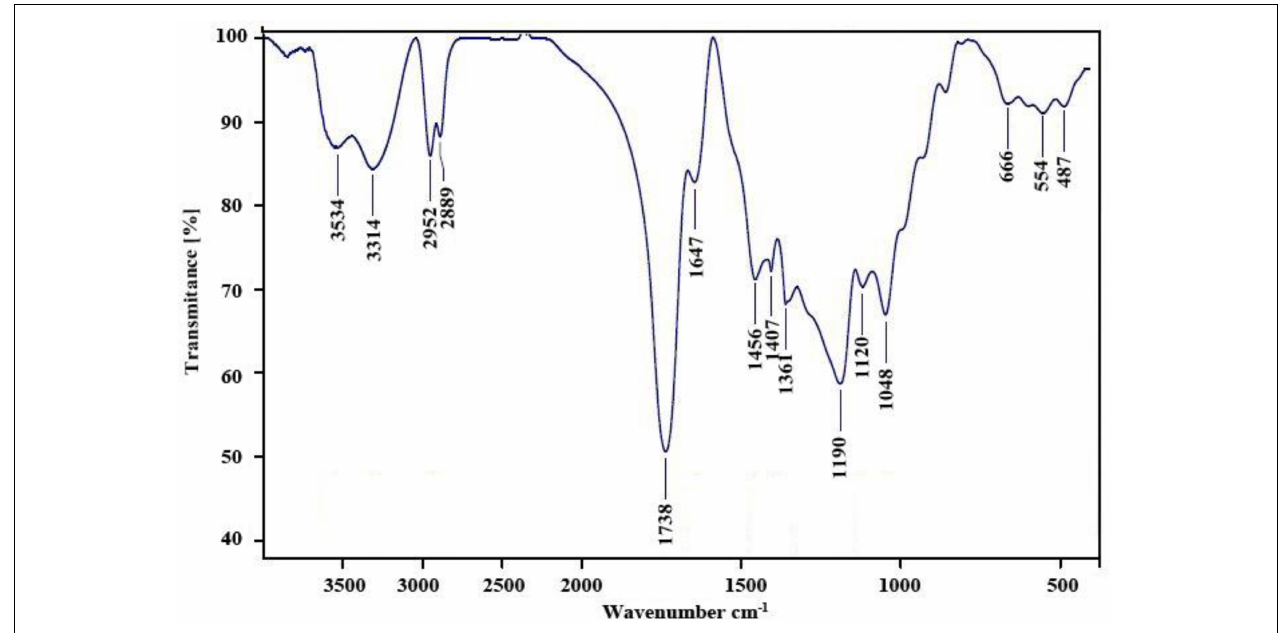
FIGURE 1 | FT-IR spectrum of